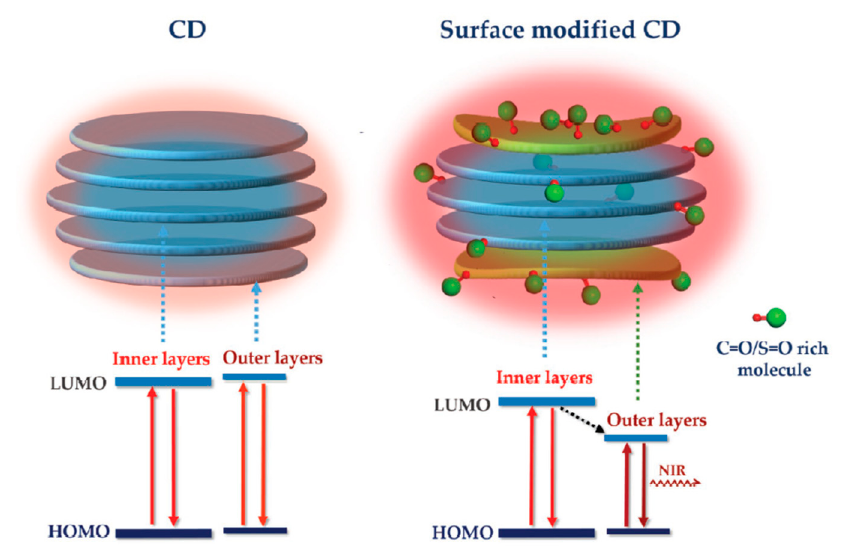
Figure 5. Non-treated CDs (left column) and CDs modified with S = O/C = O rich molecules (right column). The red (oxygen atom) and green double-bonded balls represent the C = O/S = O rich molecule (Reproduced from [129], with permission from John Wiley & Sons, Inc.).